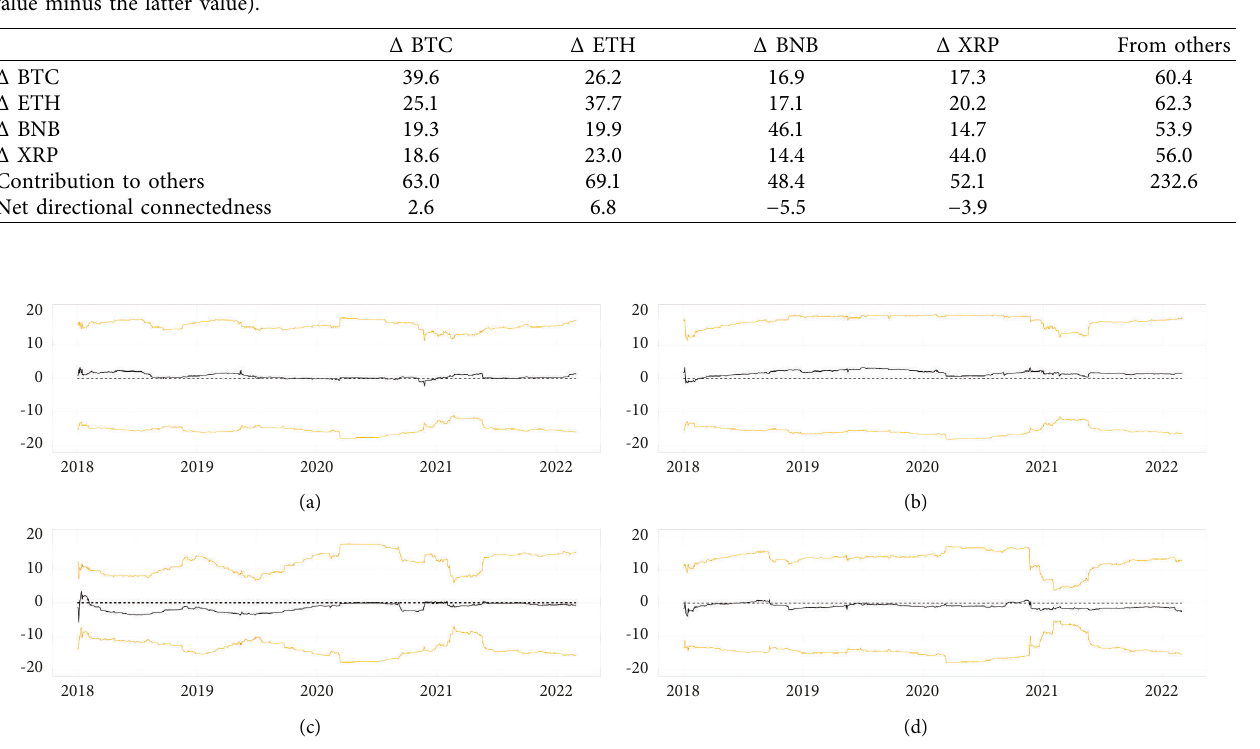
Figure 2: Directional and net connectedness. The top orange line depicts the change in this digital currency’s contribution to other digital currencies. The orange line below shows the change in the connectedness of other digital currencies that this digital currency has received. The black line in the middle shows the change in net connectedness of this digital currency over time. (a) BTC. (b) ETH. (c) BNB. (d) XRP.